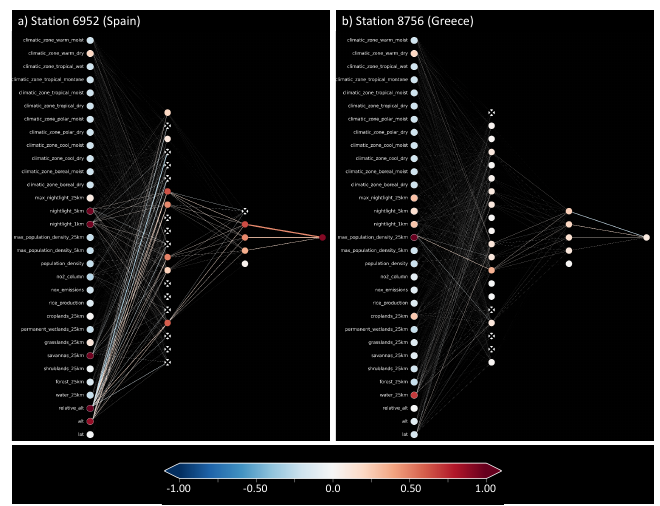
Figure 8. Trained shallow neural network while making predictions for two test samples. Plot ( a ) de- picts an accurate prediction with a small residual. Plot ( b ) shows an inaccurate prediction with a large residual.